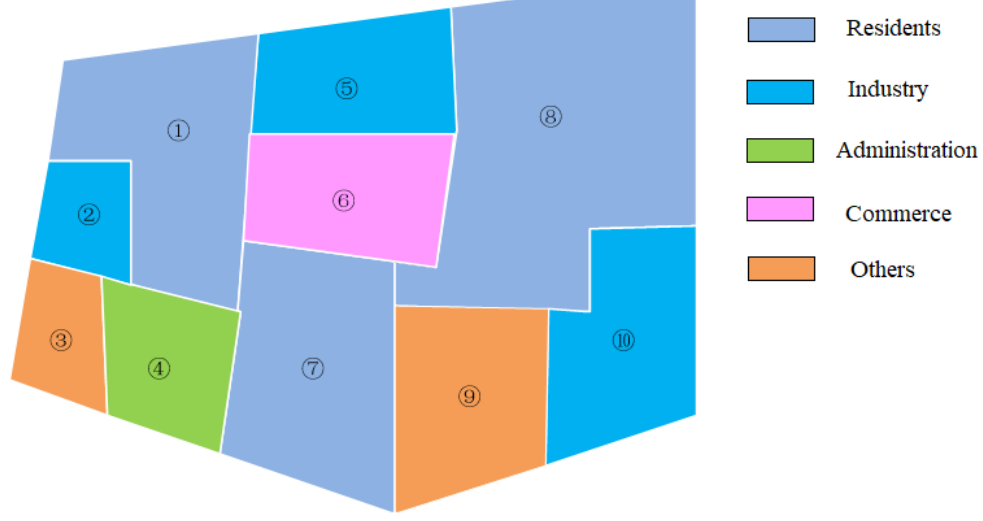
Figure 6. The result of preliminary division of decision area.